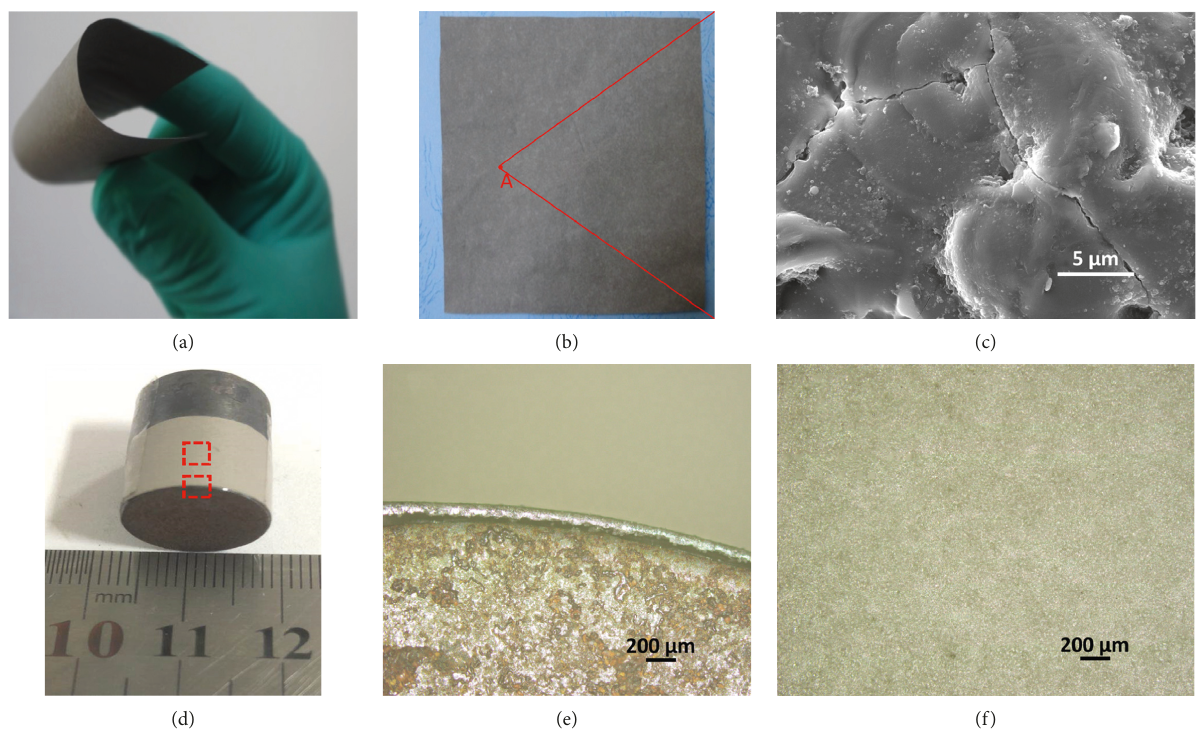
Figure 5: Bending test by hand: (a) bending test by hand; (b) the recovered composite; (c) SEM picture of the recovered composite, and the observed place has been marked as point A. Bending test by rod: (d) a tailored composite covering the rod of 16mm diameter; (e) surface morphology of the tailored composite during the bending process on the rod; (f) cross-sectional view of the tailored composite during rod